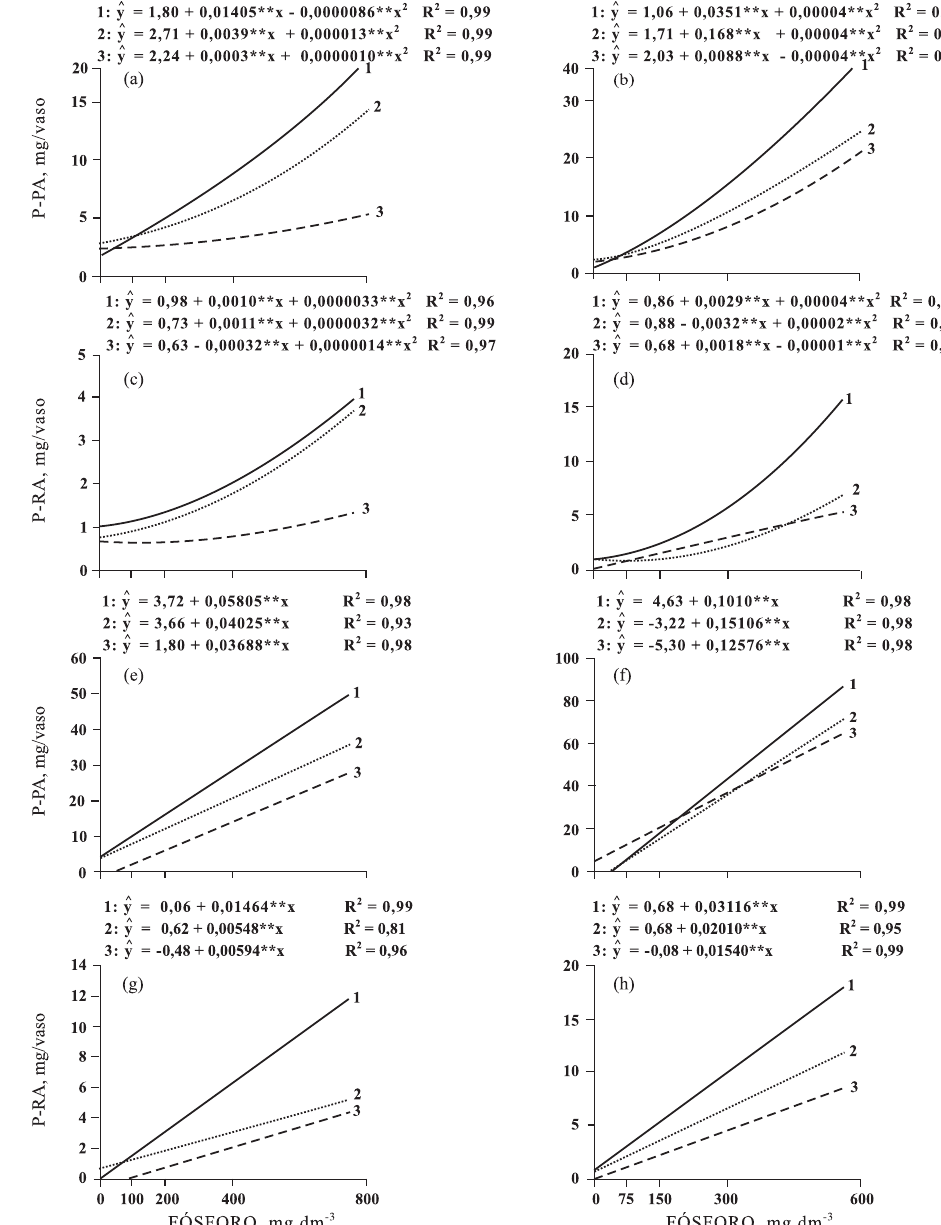
Figura 3. Fósforo acumulado na parte aérea – P-PA - (a, b) e nas raízes – P-RA - (c, d) da soja e na parte aérea (e, f) e nas raízes (g, h) do eucalipto cultivados no LV e LVA em função das doses de fósforo, de acordo com cada densidade (LV: 1=0,90, 2=1,10 e 3=1,30 kg dm -3 ; LVA: 1=1,30, 2=1,50 e 3=1,70 kg dm -3 ) (** e *: significativos a 1 e 5 %, respectivamente, pelo teste